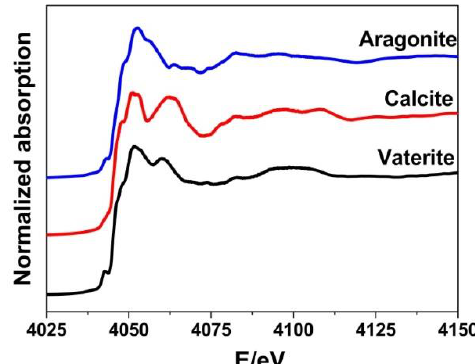
Figure A1. Ca K-edge X-ray absorption near edge structure (XANES) of three references, vaterite, calcite, aragonite.